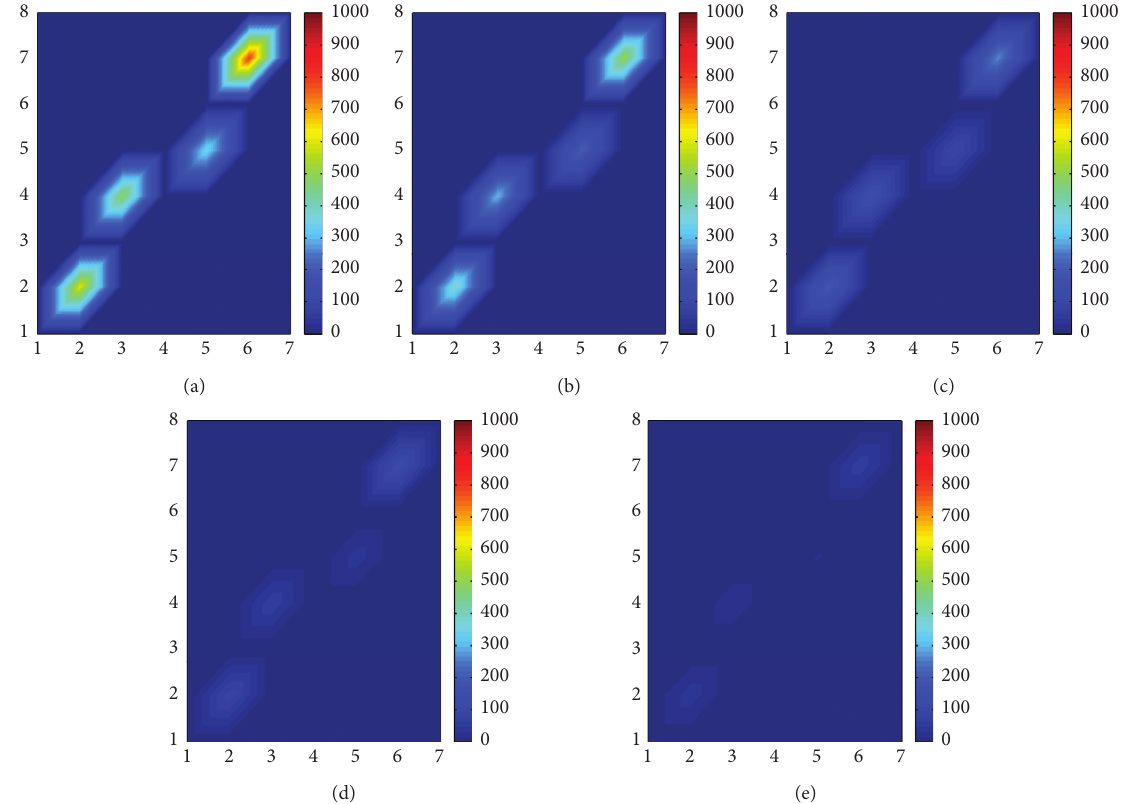
Figure 4: The biomass of prey behavior within Ω without the control. (a) t � 0. (b) t � 50. (c) t � 100. (d) t � 150. (e) t � 200.